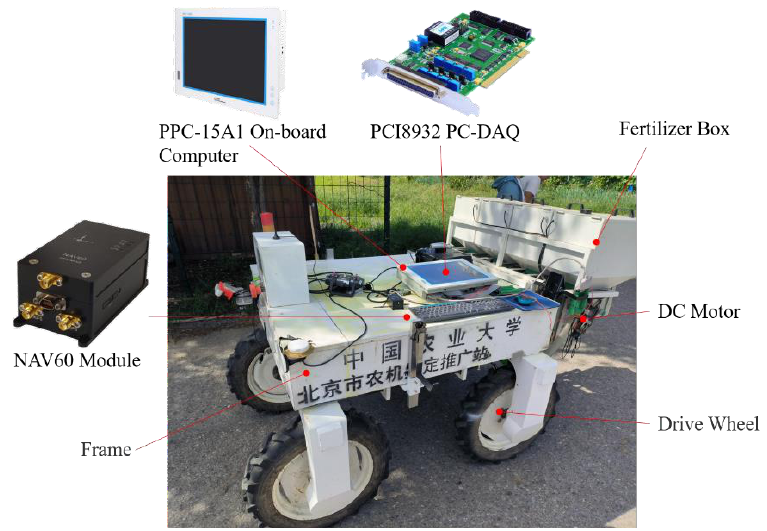
Figure 2. Fertilization experiment platform.